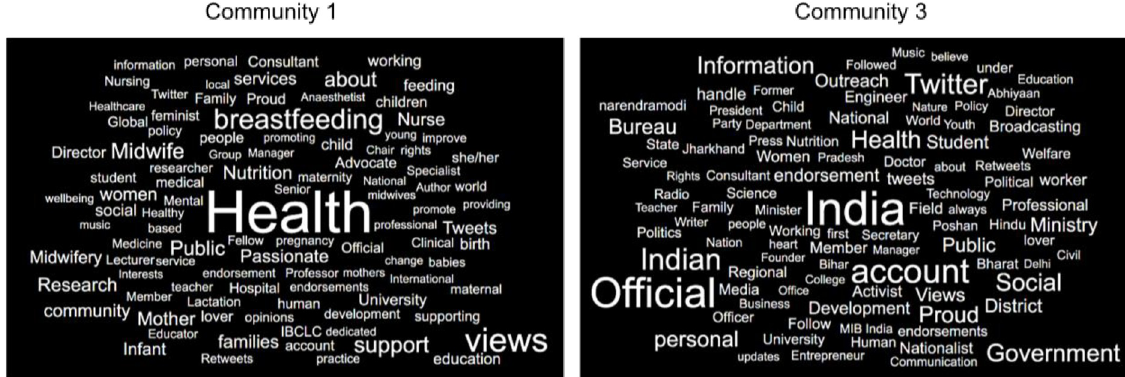
Fig 2. Profile description word clouds for users in Community 1 and 3 of the campaign